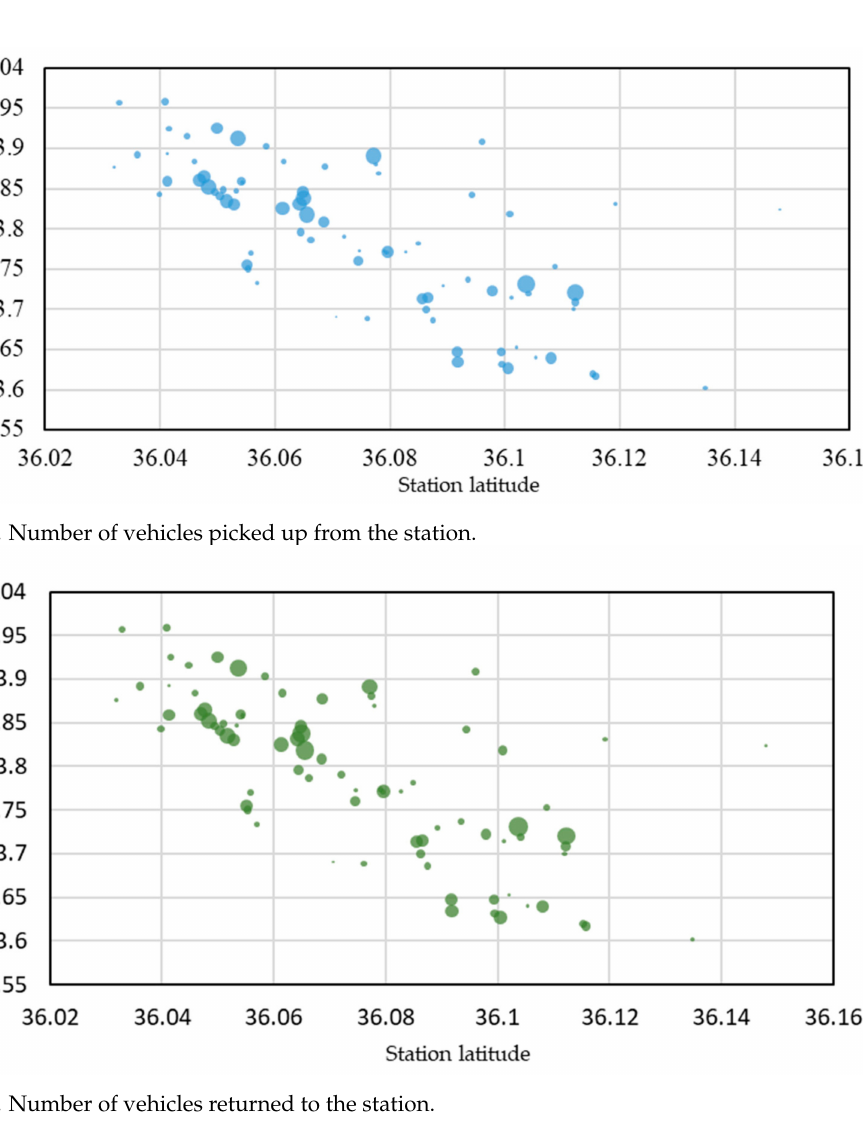
Figure 7. Number of vehicles returned to the